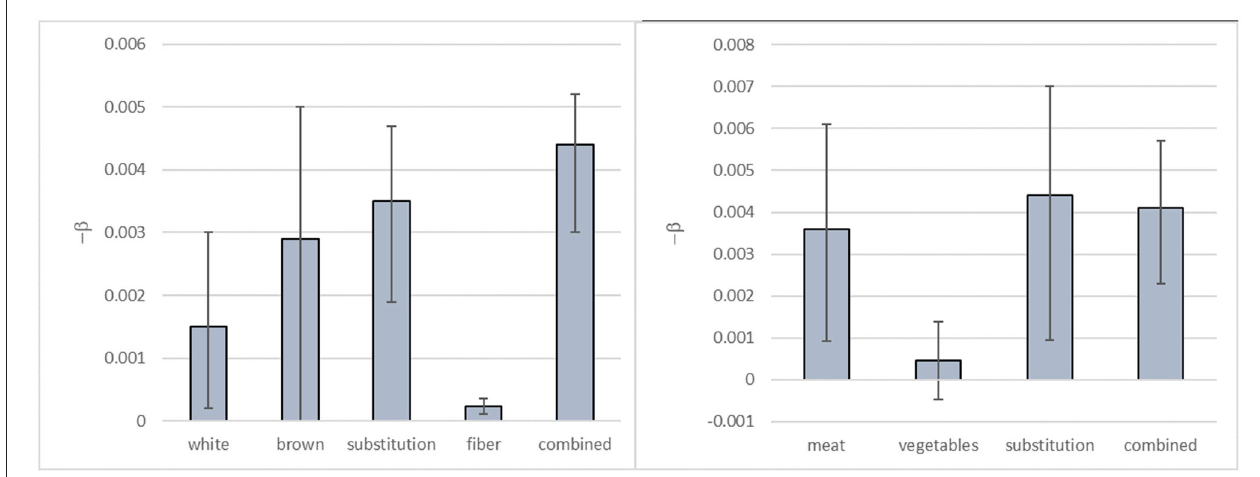
FIGURE 1 | Mean estimates and 95% CI for the β -coefficients derived for log-linear dose-response functions for the substitution of white rice by brown rice and risk of T2DM (left) and the substitution of unprocessed red meat by vegetables and risk of MI (right). Note that values of – β are given. The β -coefficients are per gram increase (white rice/vegetables), per gram decrease (brown rice/unprocessed red meat) or per gram substitution (other).